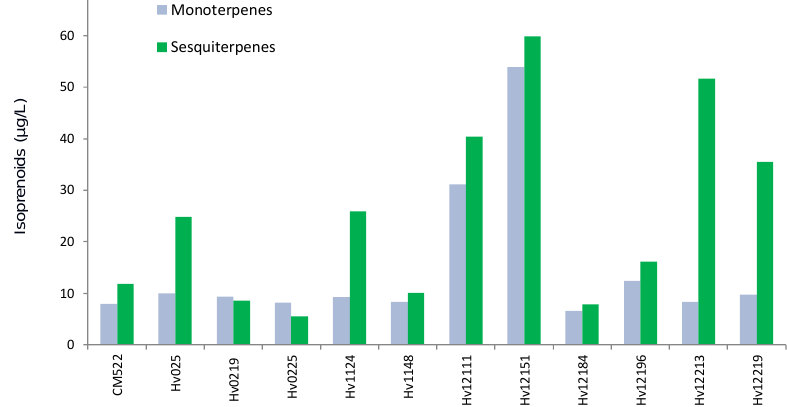
Figure 6. Production of isoprenoids (monoterpenes and sesquiterpenes) by various strains of Hanseniaspora vineae and the reference Saccharomyces cerevisiae CM522.